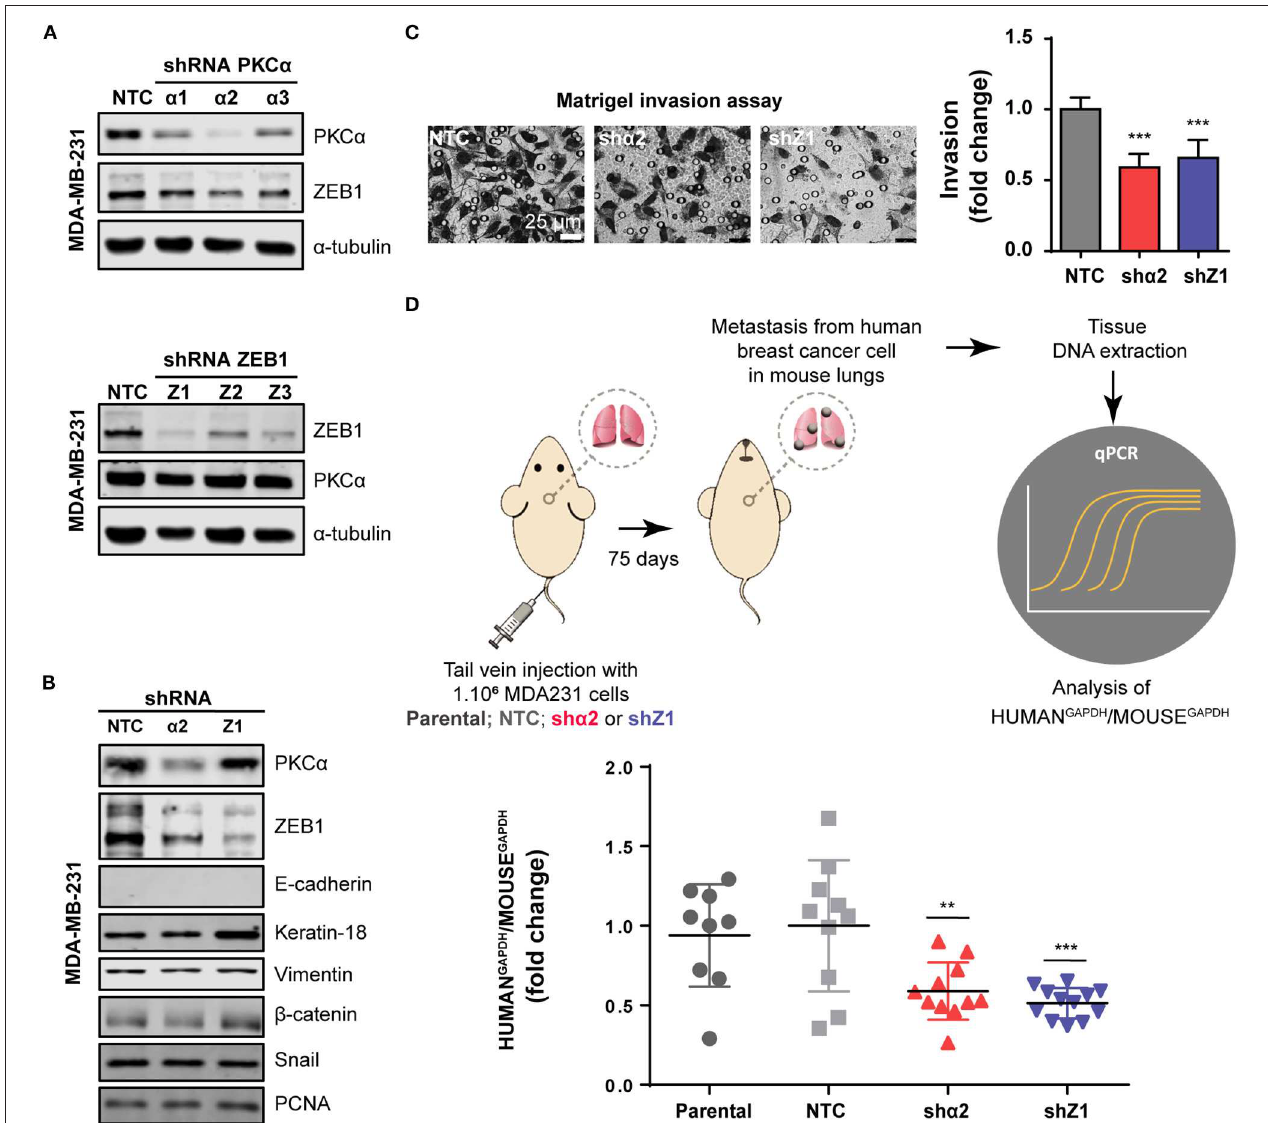
FIGURE 5 | PKC α is required for breast cancer cell metastasis. (A) Stable knockdown of PKC α (sh α 1, sh α 2, sh α 3) or ZEB1 (Z1, Z2, Z3) in MDA-MB-231 cells was achieved using the PLKO lentiviral system. (B) Western blot analysis for EMT markers. (C) Invasiveness was assessed by the Matrigel invasion assay. Graphics represent the number of invading cells per field relativized to NTC. (D) Scheme of the experimental metastasis assay in NOD/SCID mice. Seventy-five days after cell injection, murine, and human levels of GAPDH were analyzed by RT-qPCR in mouse lungs. Graphs show the ratio of Human GAPDH /Mouse GAPDH relativized to the NTC control. Results are expressed as mean ± S.D. ** p ≤ 0.01; *** p ≤